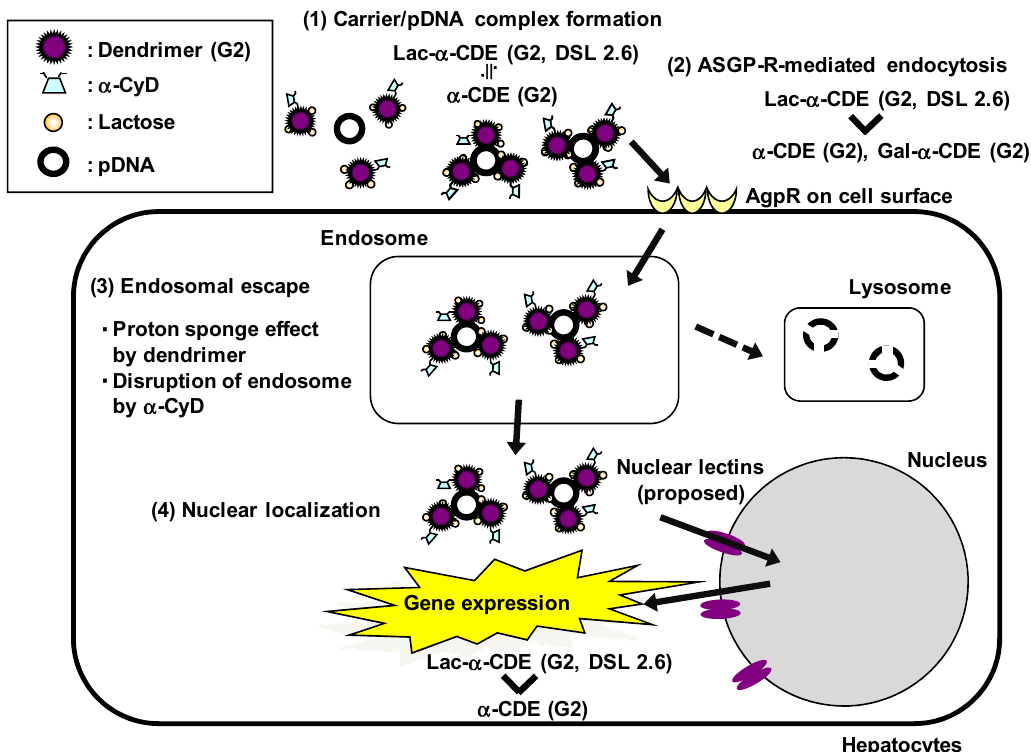
Figure 7. Proposed scheme for improved effects of gene transfer activity by Lac- α -CDE (G2, DSL